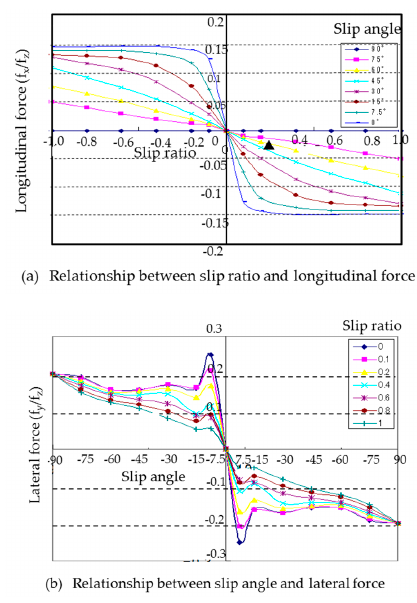
Figure 7. Slip characteristics of column-type magnetic wheel. ( a ) Relationship between slip ratio and longitudinal force where slip angle is changed from 0 degree to 90 degrees. ( b ) Relationship between slip ratio and lateral force where slip ratio is changed from 0 to 1.